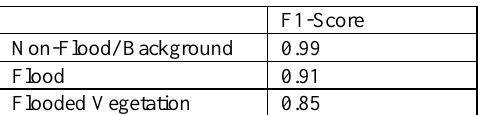
Table 4 . Model results obtained from model training and validation stage.